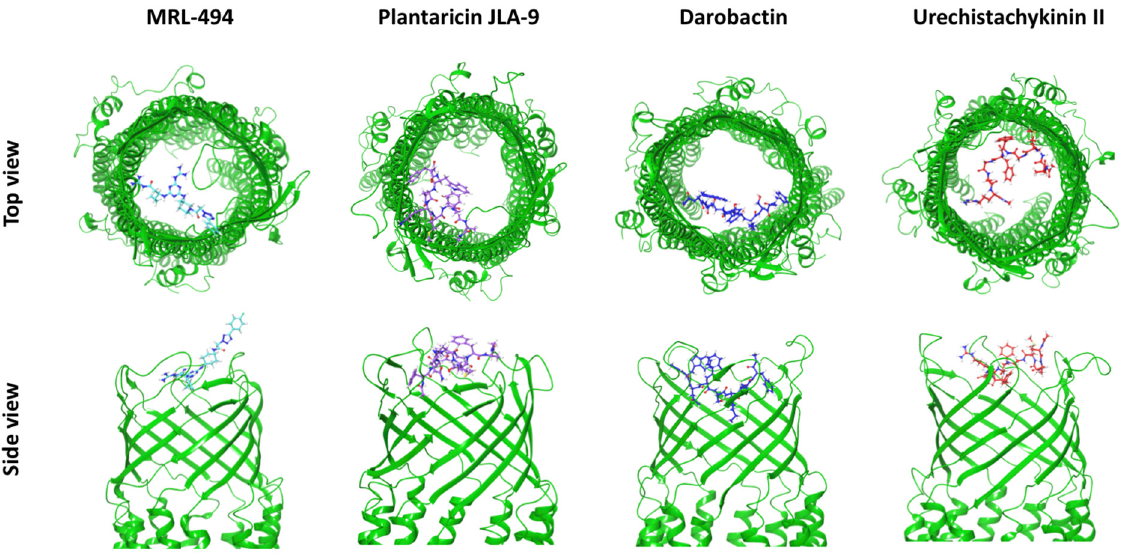
Figure 3. The structural snapshots of the selected AMPs interacting with TolC at the β -barrel sites. TolC efflux pump protein was shown as a green ribbon diagram. AMPs were presented via balls and stick diagrams.